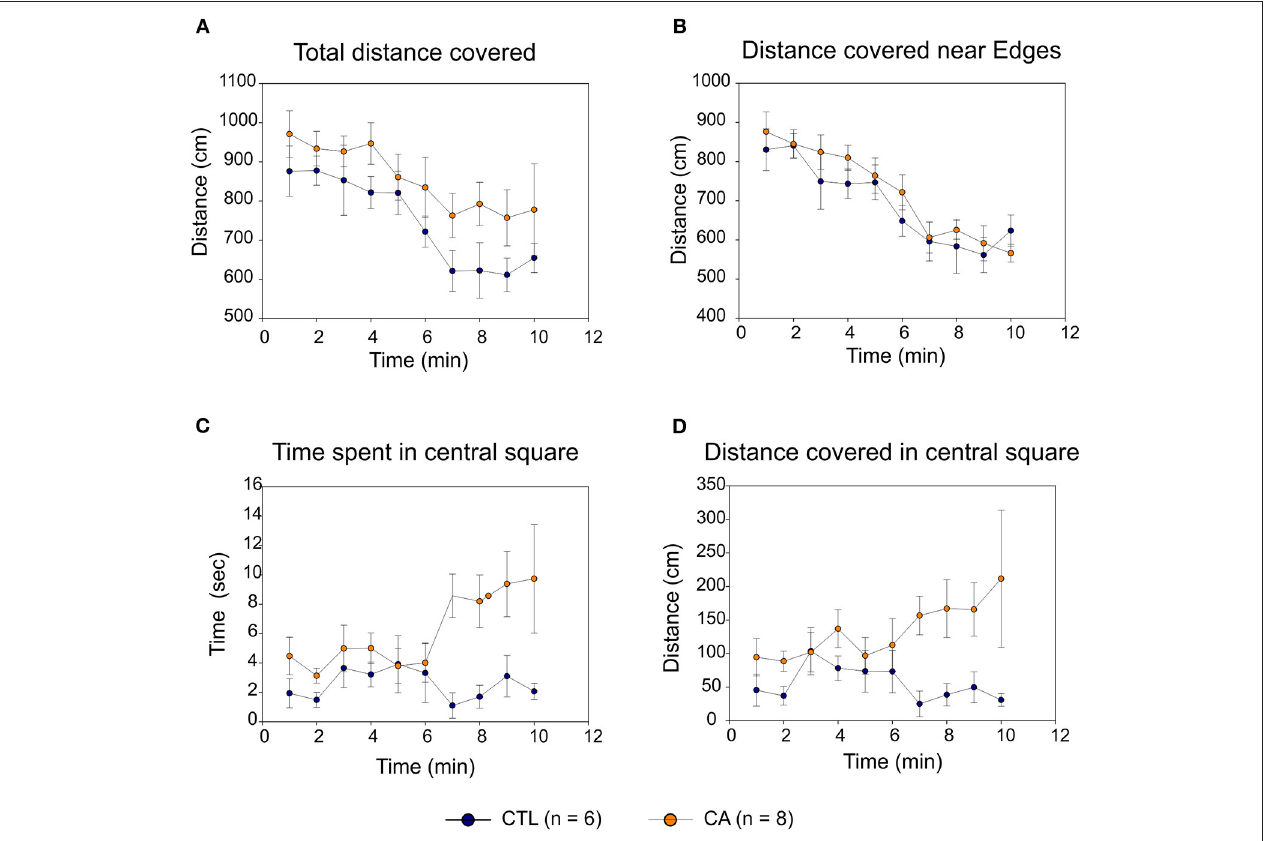
FIGURE 4 | Open Field behavioral testing. The graphs indicate distances covered in the open field over time (A) ; distances covered near the field perimeters (B) ; times spent in the central square (C) and distances covered in the central square (D) for the control group (CTL; blue symbols) and the cardiac arrest (CA) group (orange symbols). Values are expressed as Mean ±